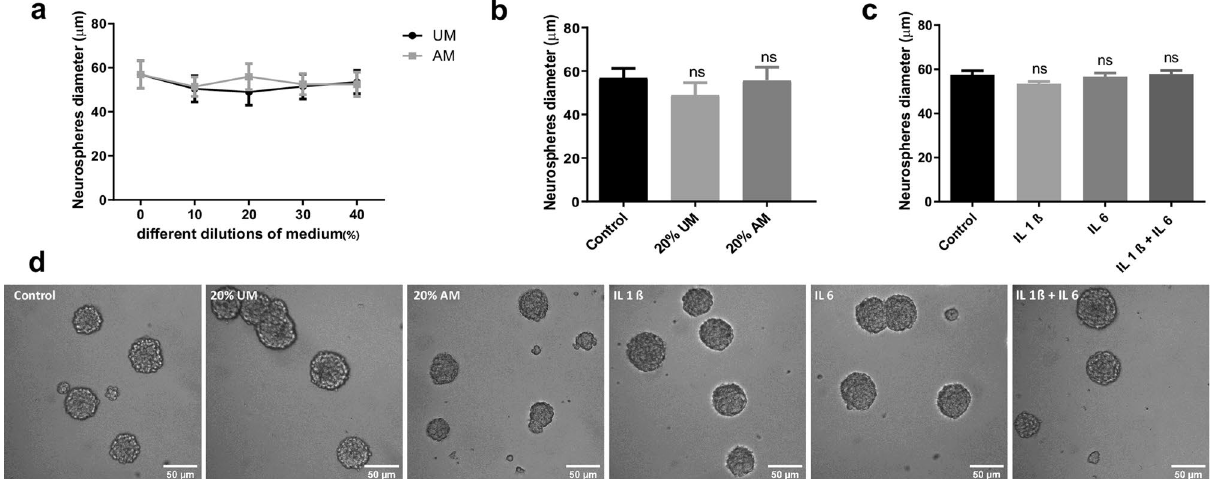
Figure 1. NSCs proliferation is not affected by inflammation. ( a ) After incubating the NSCs with different dilutions of medium obtained from LPS-stimulated macrophages (AM) or without stimulation as a control (UM) during 96 h, proliferation was analysed by measuring Neurosphere’s diameter. Graph represents the neurosphere’s diameter measured in three independent experiments. ( b ) Diameter of the Neurospheres of NSCs exposed to 20% V/V of UM and AM or control during 4 days. Graph represents the neurosphere’s diameter measured in three independent experiments. ns no statistical significance. ( c ) Diameter of the Neurospheres of NSCs exposed to 50 ng/ml of IL-1β and/or IL-6 during 96 h. Graph represents the neurosphere’s diameter measured in three independent experiments. ns no statistical significance. ( d ) Representative images (× 20) of neurospheres incubated in the indicated conditions. Scale bars: 50